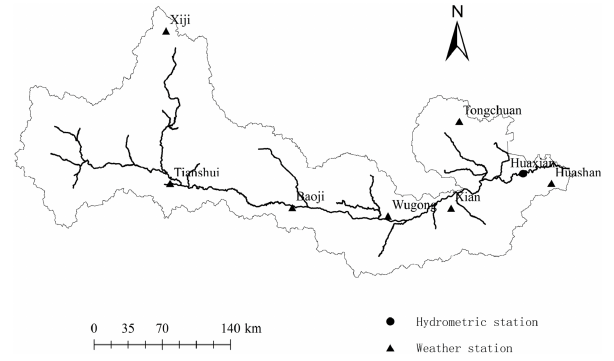
Figure 1. Location of the meteorological and hydrological stations used in this